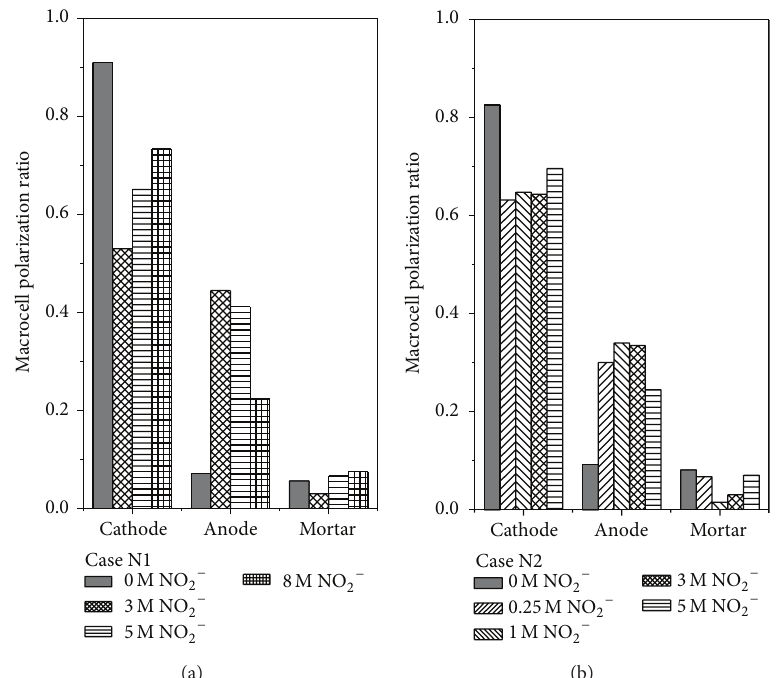
Figure 8: Effect of nitrite concentrations on the macrocell polarization ratios of cathode, anode and mortar. (a) Case N1, (b) Case N2.